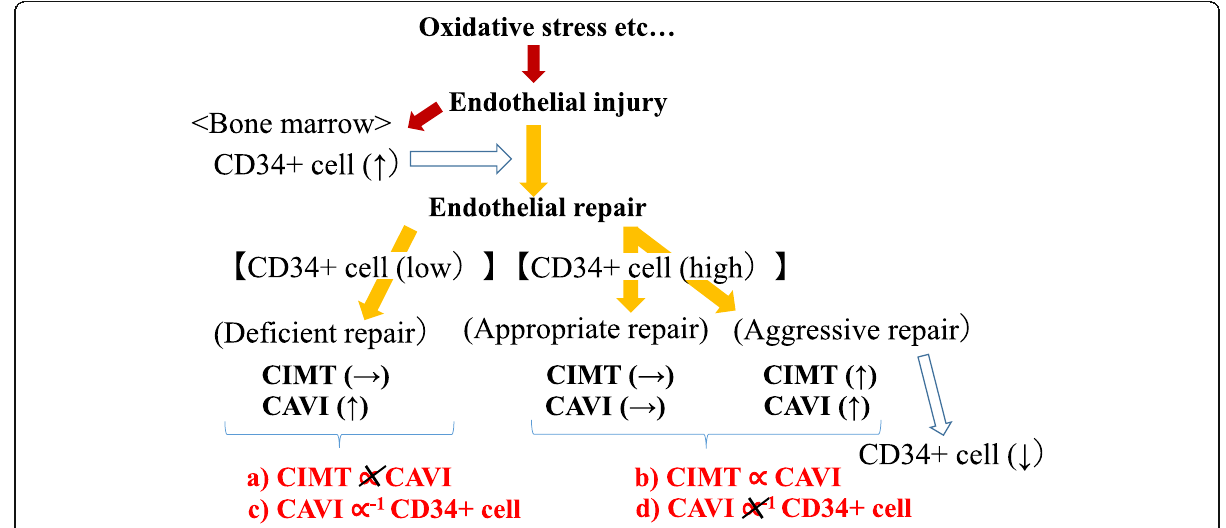
Fig. 2 Functional arterial stiffness and organic arterial stiffness in relation to circulating CD34-positive cells [28]. CAVI, cardio-ankle vascular stiffness index; CIMT, carotid intima-media thickness; CD34+,